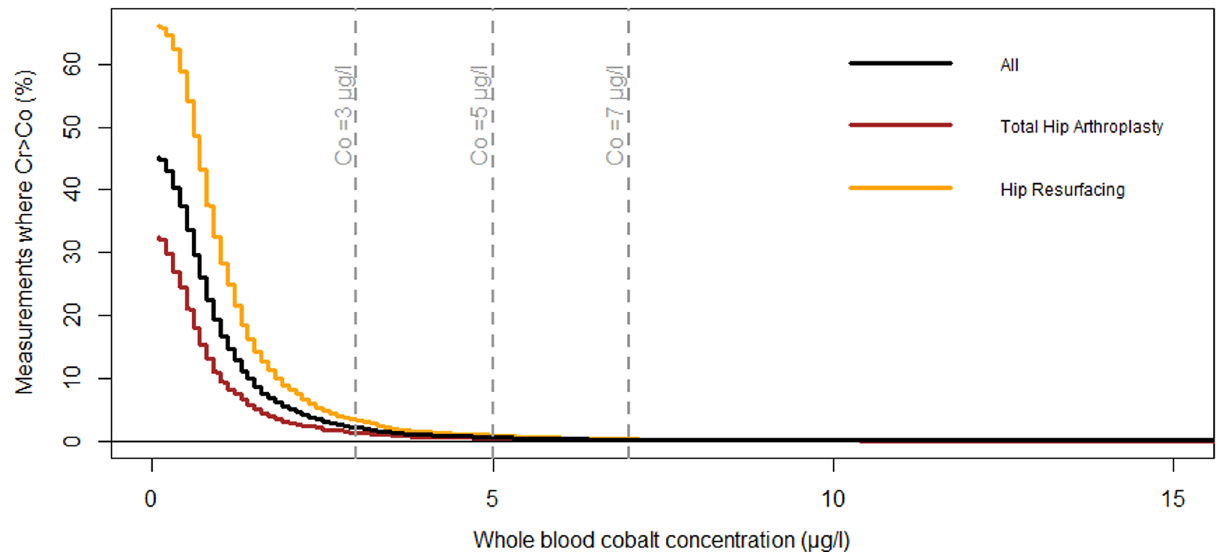
Figure 1. The relationship between whole blood cobalt (Co) concentration and the percentage of measurements where chromium (Cr) concentration is higher than Co. At a certain whole blood Co value, the curve tells us what percentage of the measurements with Co above the value have higher whole blood Cr than Co. “All” corresponds to all measurements performed without or before revision surgery. Figure drawn with R (Version 3.5.1) 21 .